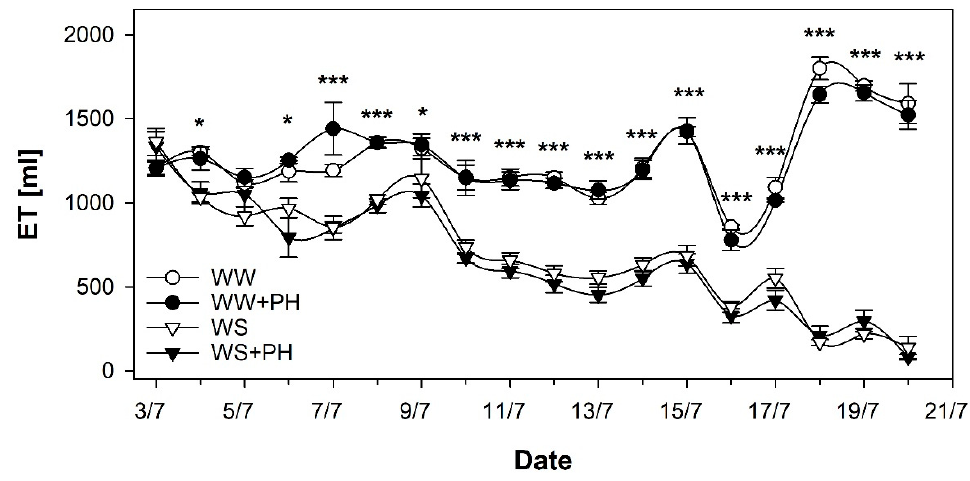
Figure 1. Effects of water stress (WS) compared with well-watered conditions (WW) and PH application, on soil water content. The experimental pots were weighed daily before soil water adjustment in order to measure the daily water loss by evapotranspiration (ET). Values are means ± SE ( n = 8). Asterisks indicate significant differences among treatments according to repeated measurements ANOVA ( p < 0.0083, p < 0.002 and p < 0.0008 after sequential Bonferroni adjustment for α = 0.05 (*) and α = 0.005 (***), respectively).